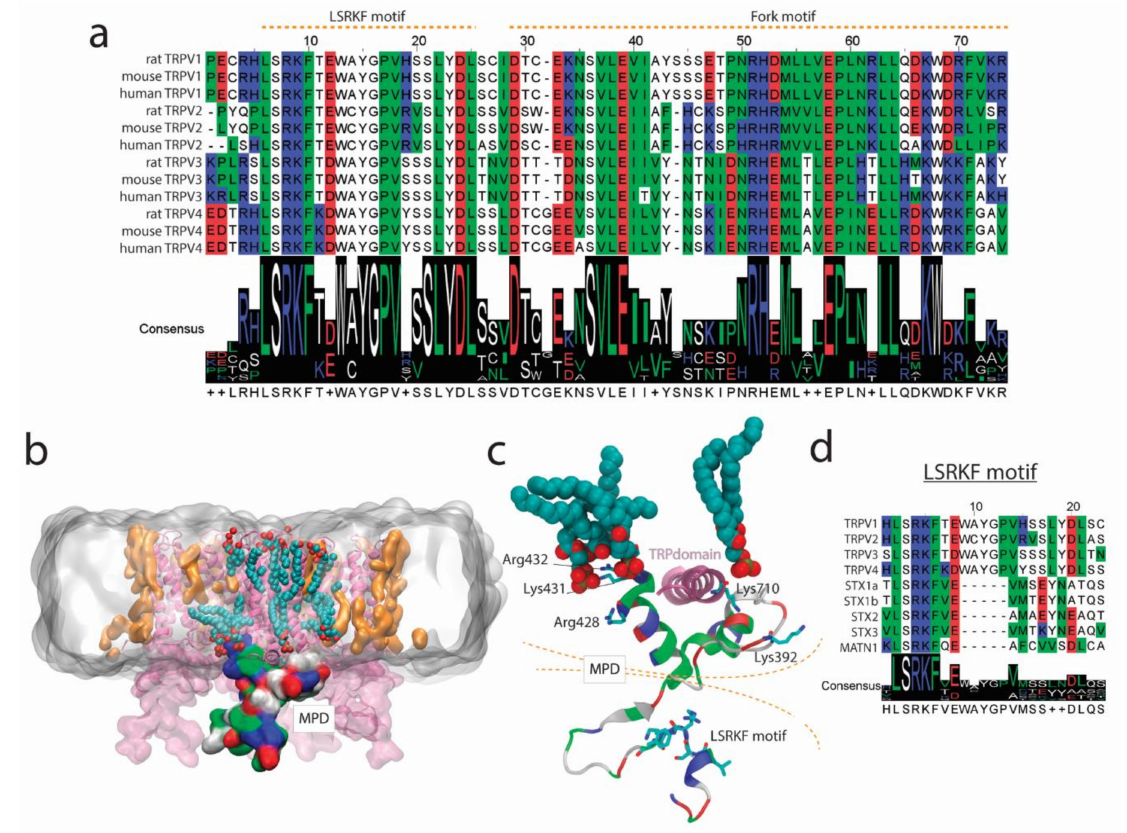
Figure 4. ( a ) The MPD domain is highly conserved within the TRPV1–4 subgroup. An orange dotted line delimits the LSRKF and Fork motifs. ( b ) Illustrative tridimensional depiction of TRPV1 (protein data bank (PDB) code 5IRZ, in pink surface representation) embedded in a DPPC/DPPA bilayer (grey surface) resulting from a membrane molecular dynamics (MD) equilibration trajectory (1 nanosecond). The MPD domain for Chain A is depicted as a colored surface. DPPA molecules within 5 Å of the protein are depicted in orange, except for those DPPA molecules within 5 Å of Chain A for TRPV1, which are depicted as Van der Wals (VdW) spheres colored by element (C in cyan; P in golden; O in red). ( c ) Representation of the MPD of TRPV1 highlighting the residues interacting with DPPA molecules. ( d ) Multiple sequence alignment for human sequences containing the LSRKF motif (STX, syntaxin; matrillin 1 or cartilage matrix protein (MATN1)). The color code for MSA and structure residue representation is the following: red, negatively charged; blue, positively charged; white, polar non-charged; green,